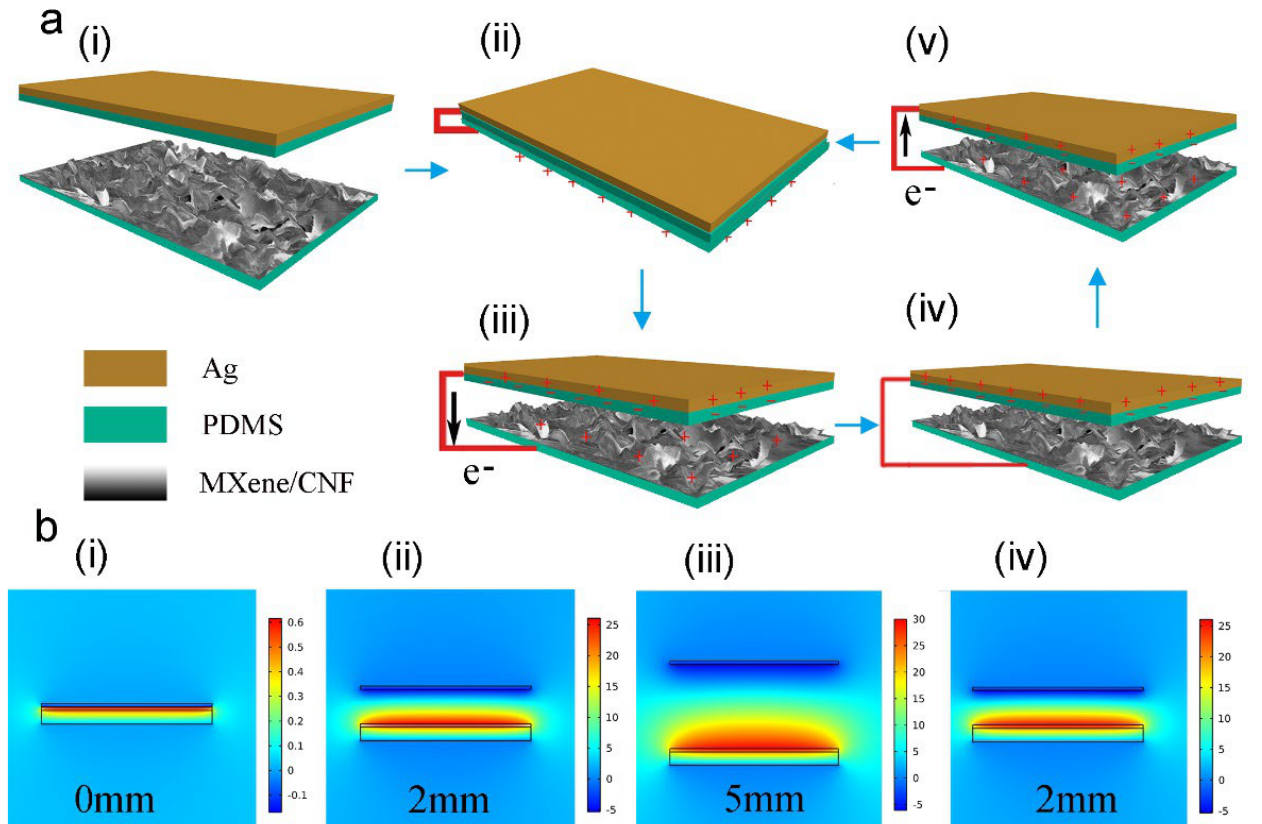
Figure 3. Working mechanism of the MCM-TENG. ( a ) The charge distribution and charge transfer in the contact–separation mode. ( b ) The potential difference between the two electrodes in the contact–separation mode.